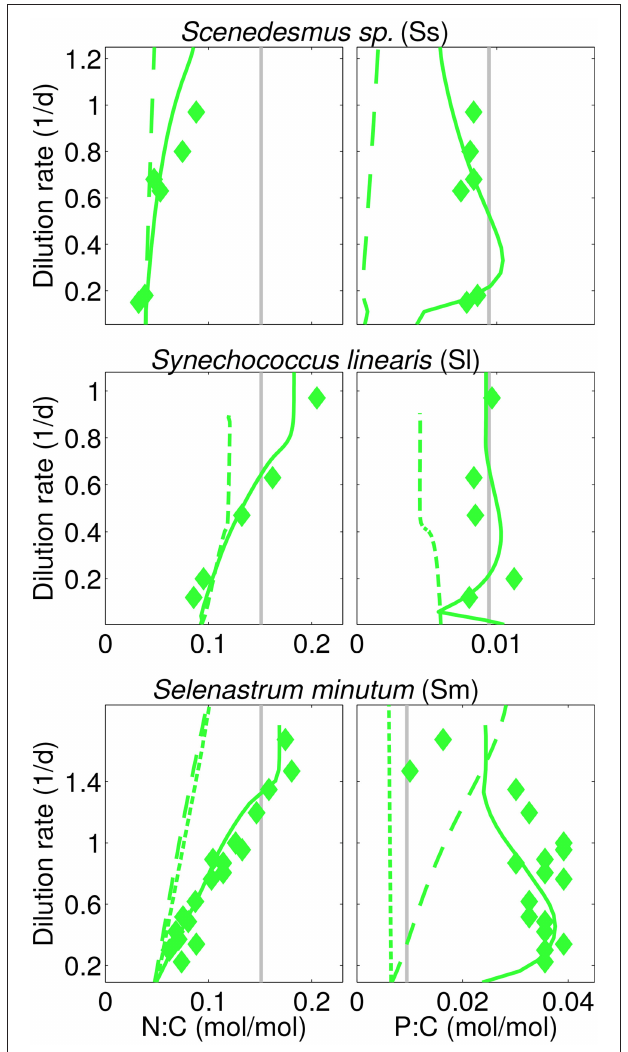
FIGURE 4 | Calculated (steady-state) and reported N:C, P:C in three N-limited cultures analog to Figure 3 (“I=38” experiment for S. linearis ). In addition, two physiological scenarios are displayed using (a) long-dashes (Sm, Ss): simulations with fixed independence n =4, and (b) short-dashes (Sm, Sl-38): without optimality regulation.